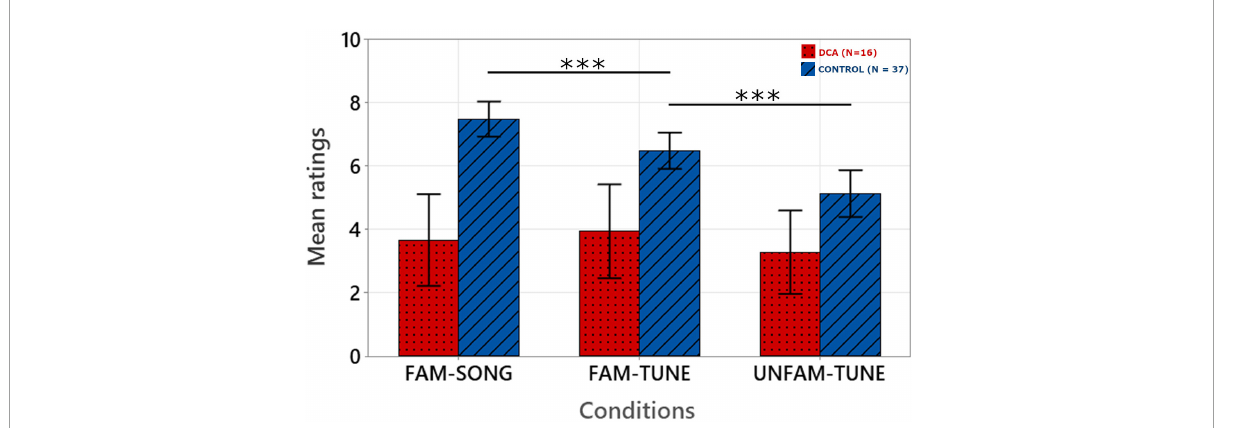
FIGURE2 Mean ratings on the melodic reproduction task as a function of experimental conditions. The error bars correspond to the standard error of the mean. Ratings were given by 10 blind judges on a continuous scale from 0 (very poor performance) to 10 (very good performance) and were then averaged. ∗∗∗ p < 0.001.